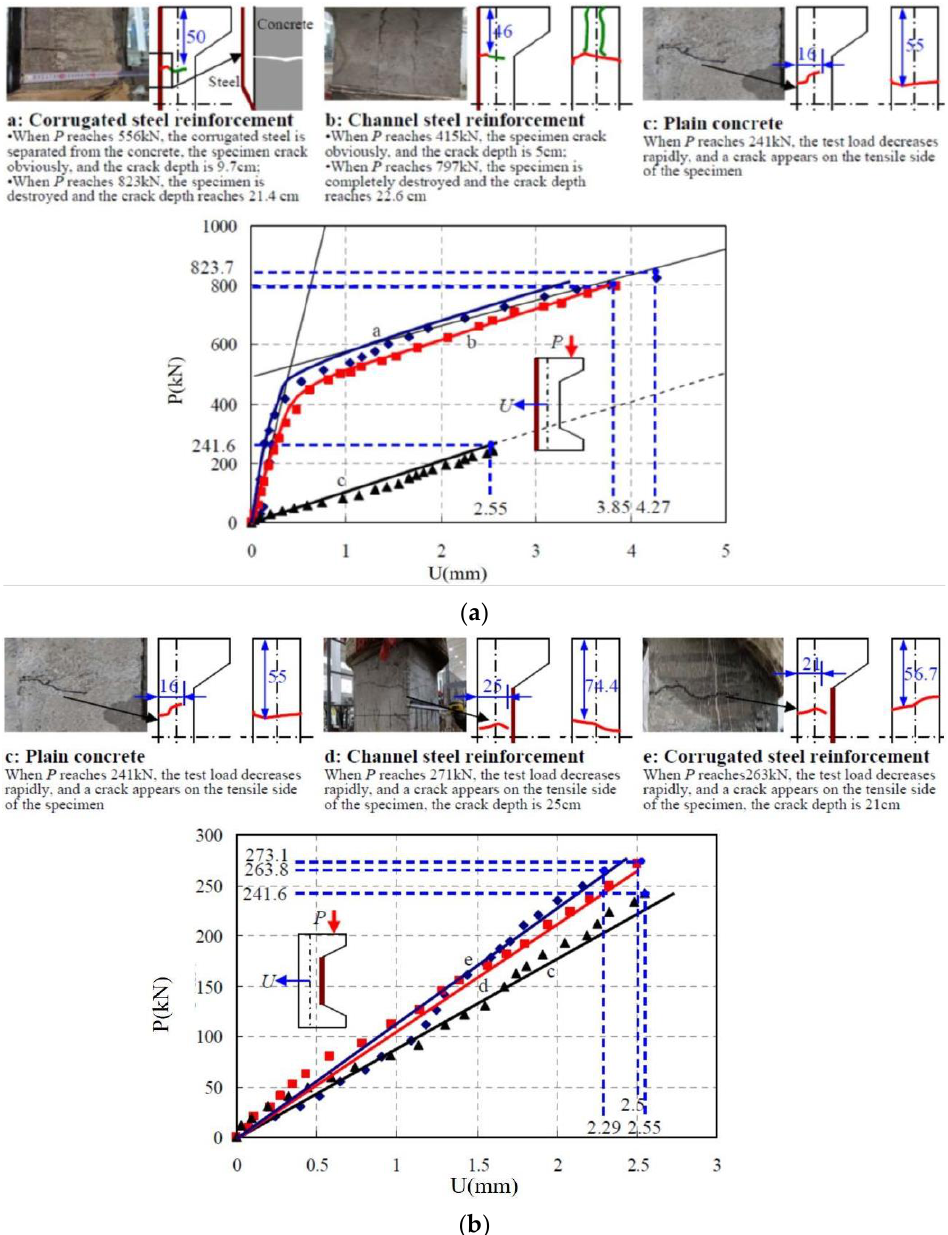
Figure 7. Load – deflection test results for each specimen. ( a ) Tension side reinforcement; ( b ) Com- pression side reinforcement.